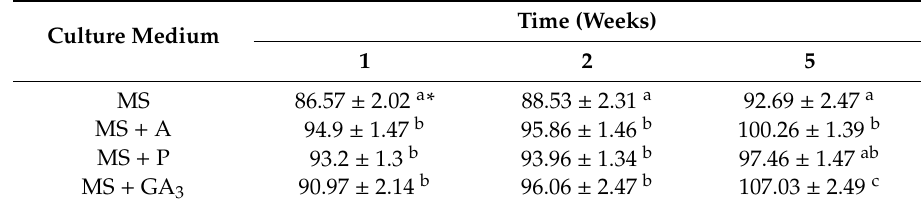
Table 2. E ff ect of GA 3 and GA inhibitors (10 µ M): ancymidol (A) and paclobutrazol (P) on bulb fresh weight (mg) cultured for 1, 2 and 5 weeks at 7 ◦